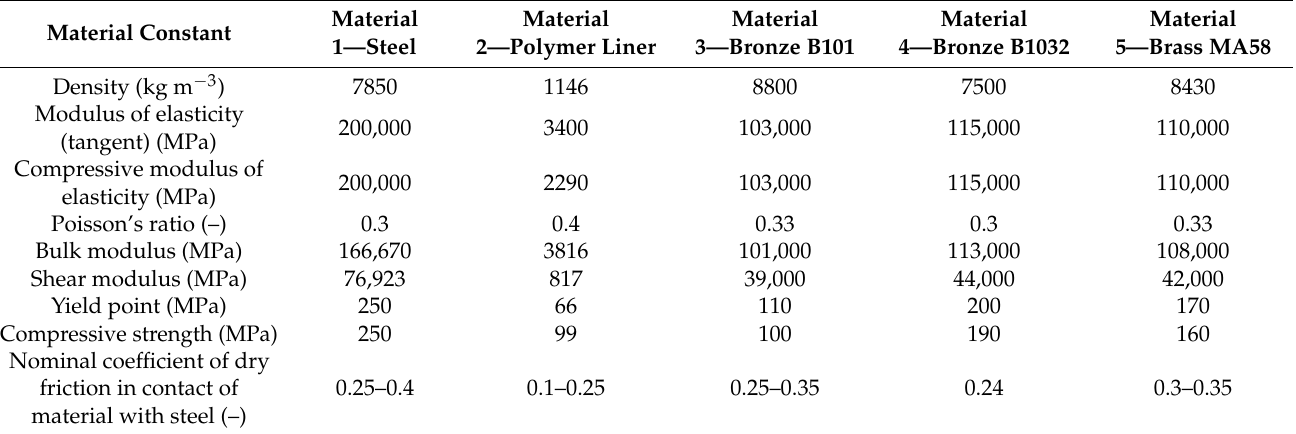
Table 1. Material